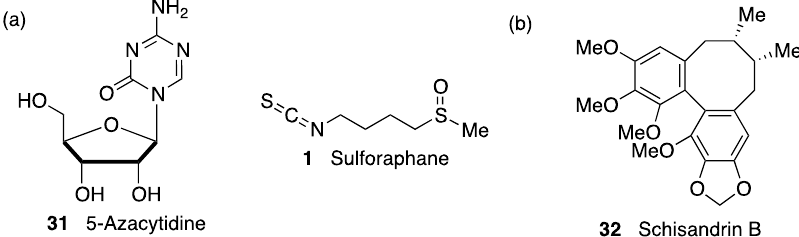
upregulation of NRF2 expression. ( b ) Schisandrin B exerted neuroprotection in a Parkinson’s disease (PD) cell model by blocking the suppression of NRF2 activity by the microRNA